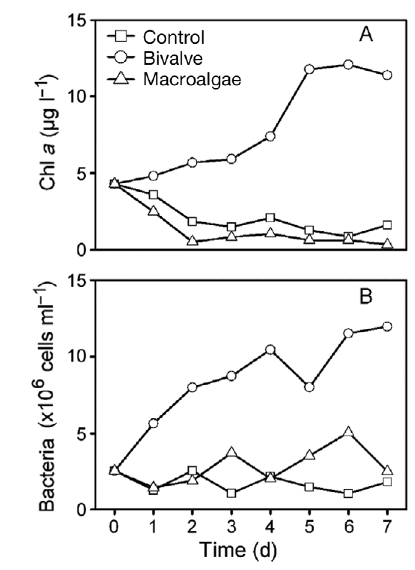
Fig. 7. Variations in (A) chl a biomass and (B) bacterial abun- dance in the enclosure experiments over time